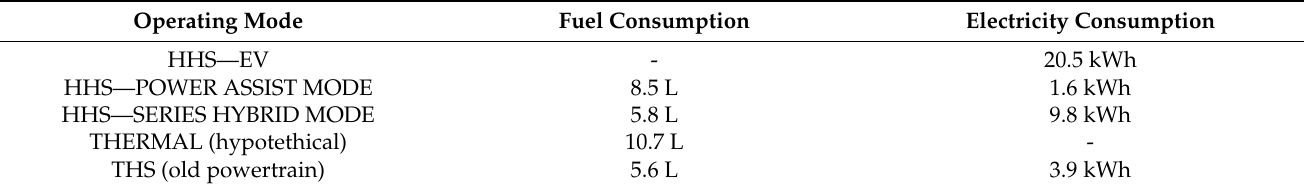
Table 3. Consumption of fuel and electricity for different operating